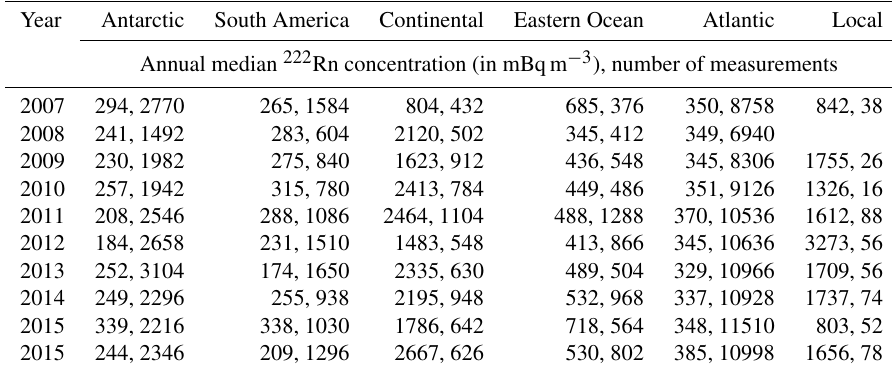
Table 3. Annual median 222 Rn concentrations. Year